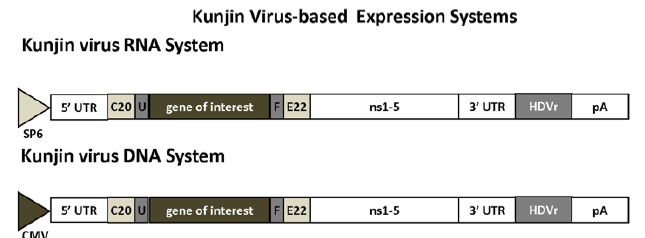
Figure 2. Kunjin Virus-Based Expression Systems. Expression vector based on Kunjin virus RNA and DNA expression systems. 3′ UTR, 3′ untranslated region; 5′ UTR, 5′ untranslated region; C20, first 20 amino acids of KUN C protein; CMV, cytomegalovirus promoter; E22, 22 last amino acids of KUN E protein; F, FMDV (foot-and-mouse disease virus) 2A autoprotease; HDVr, hepatitis delta virus ribozyme; ns1-5, nonstructural proteins; pA, polyadenylation signal; SP6, SP6 phage RNA polymerase promoter; U, mouse ubiquitin sequence. Figure 3. Measles Virus-Based Expression system. The measles virus structural proteins are flanked by T7 RNA polymerase promoter and the T7 RNA polymerase terminator. Foreign genes can be inserted between the P and M or H and L genes. H, MV hemagglutinin; L, MV L protein; M, MV matrix protein; N, MV nucleocapsid protein; T7, T7 RNA polymerase promoter; T7 term, T7 RNA polymerase terminator.